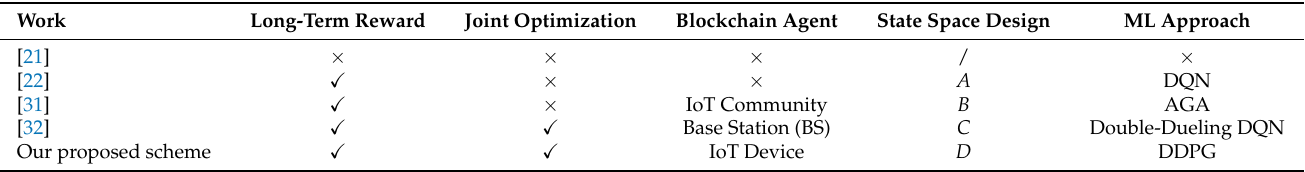
Table 1. A comparison with related works.